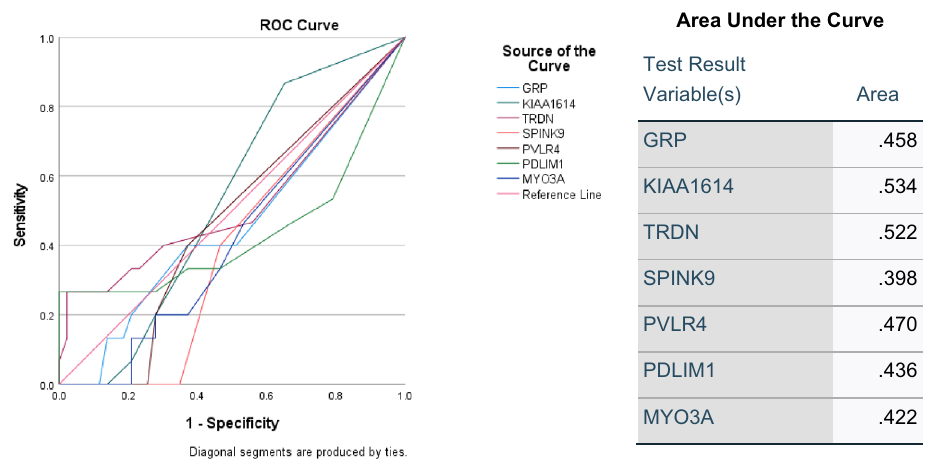
Figure 7. ROC curves of common upregulated DEGs between all T1DM complications. (A) ROC curves of upregulated common genes. (B) Area under the ROC curve. ROC receiver operating characteristic.